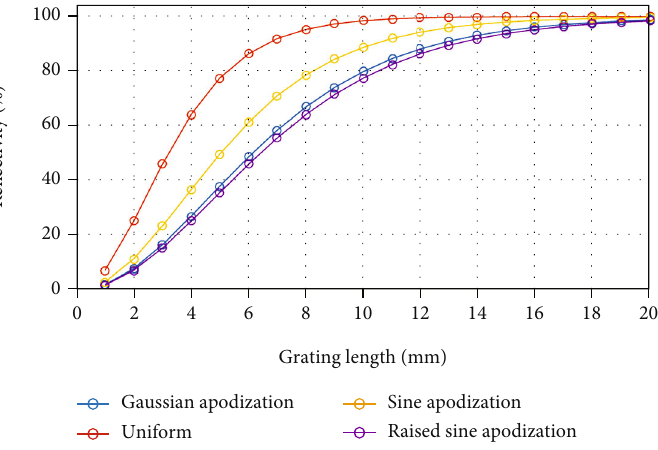
Figure 9: Re fl ectivity versus the grating length of FBG.